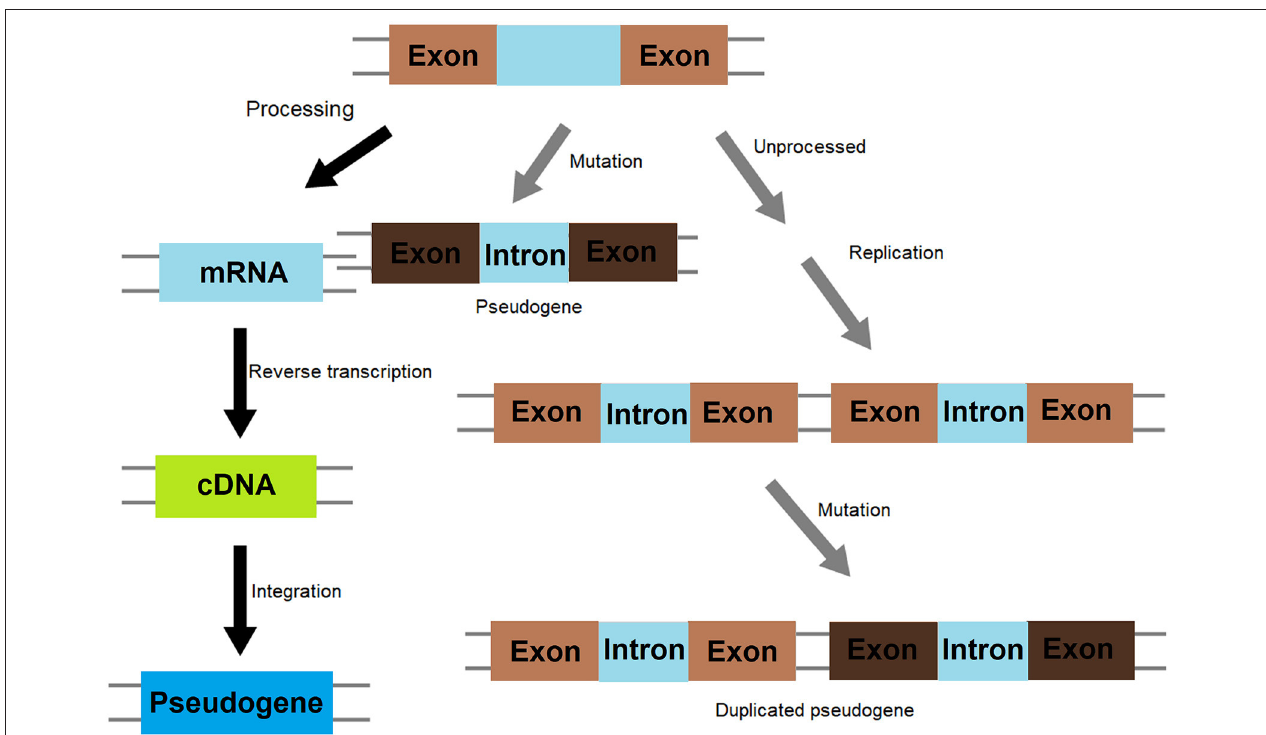
FIGURE 1 | Molecular mechanism of pseudogene